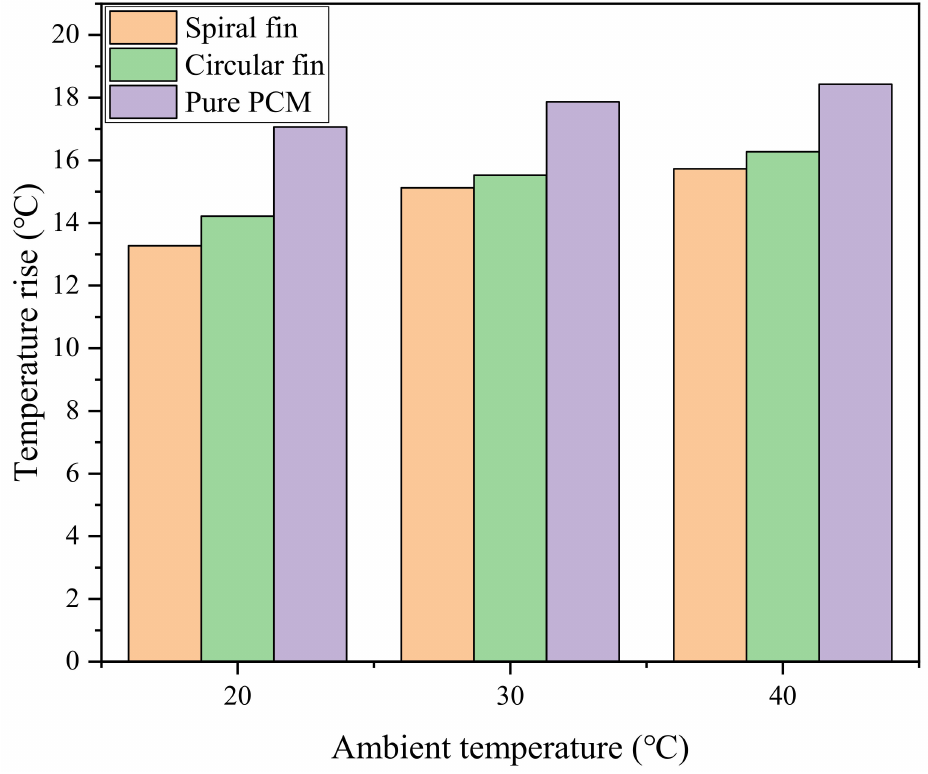
Figure 11. Maximum battery temperature rise for all three